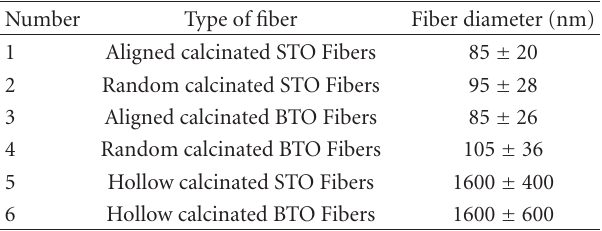
Table 1: Variation in diameter of calcinated fibers (at 500 ◦ C) according to morphology.